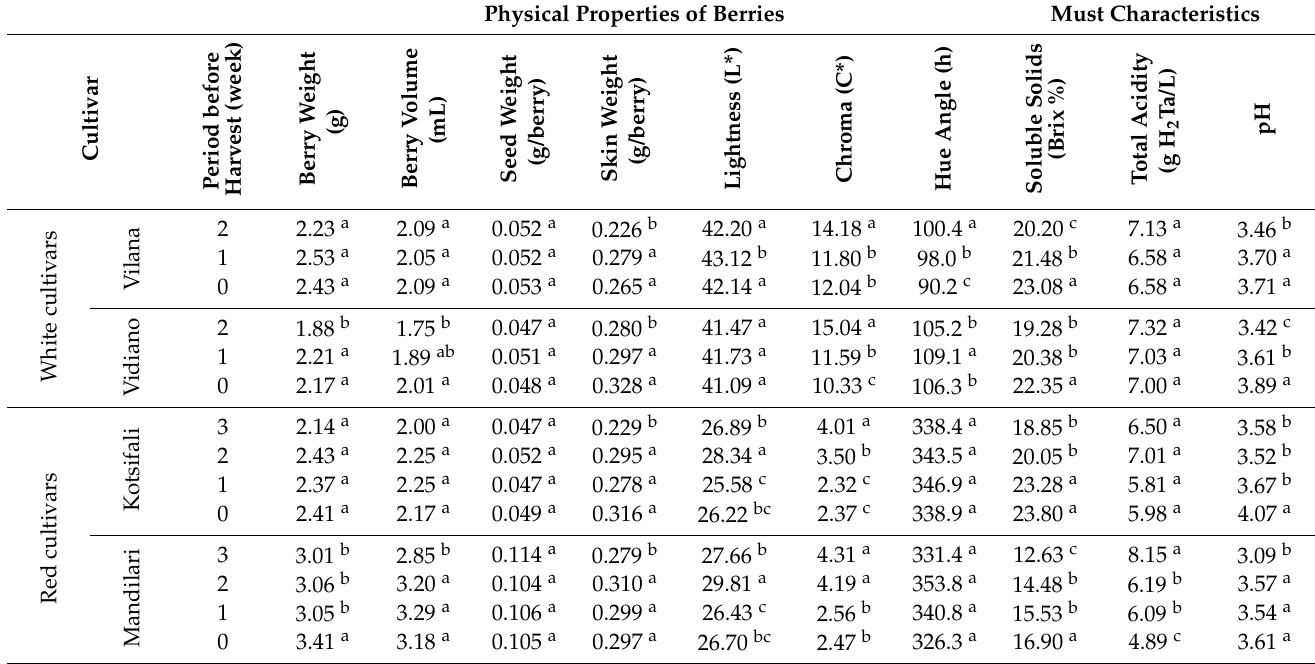
Table 1. Physical properties, berry color and must characteristics of Vilana, Vidiano, Kotsifali and Mandilari cultivars during the last weeks before